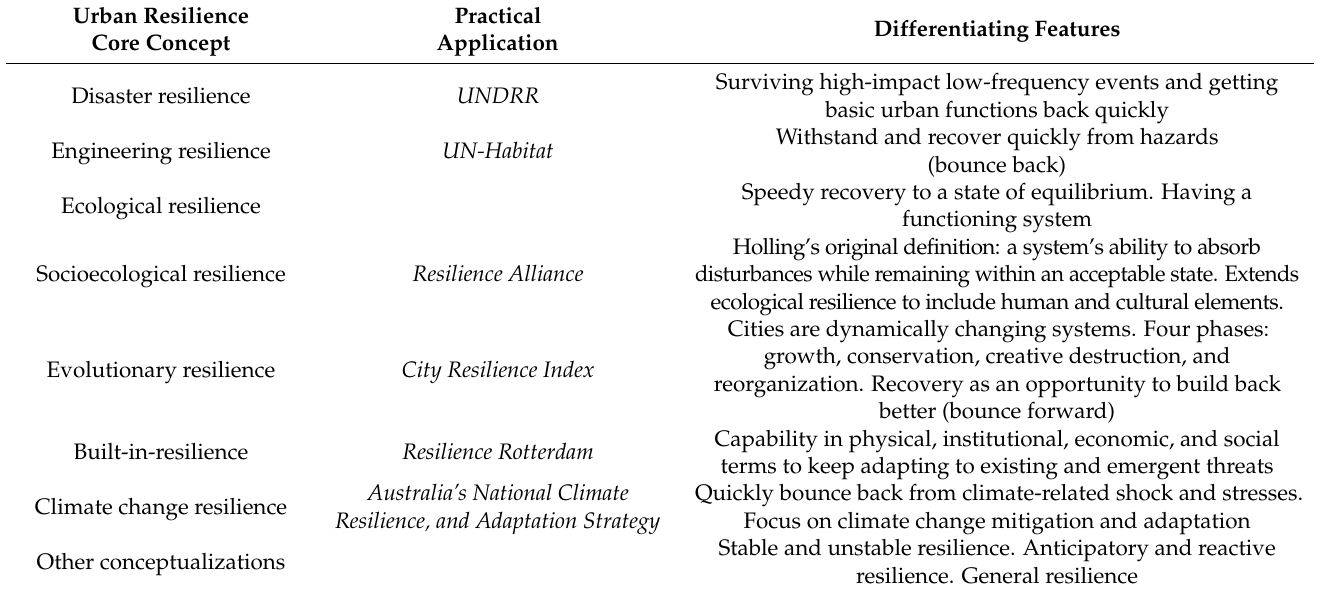
Table 1. Seven approaches to urban